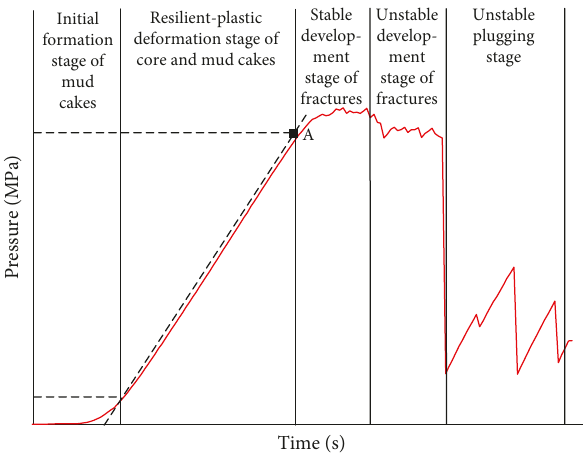
Figure 23: Changes in the core fracturing